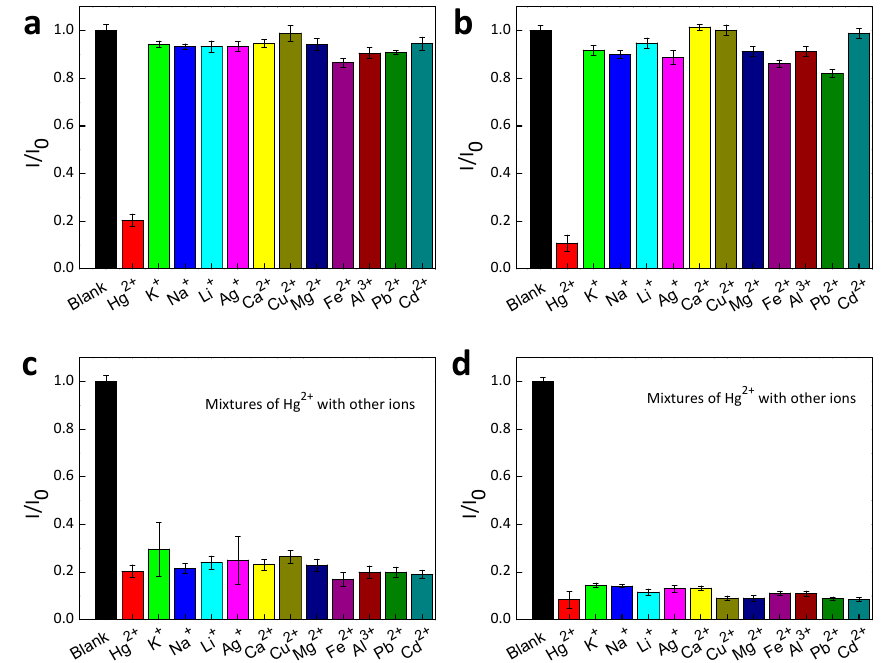
Figure 5. Selectivity test for M1 ( a , c ) and M1Q ( b , d ) in the presence of single ( a , b ) and co-existing ( c , d ) metal ions. The error bars represent the standard deviation of three independent measurements. [M1] = [M1Q] = 1.0 × 10 − 6 M, [metal ion] = 2.0 × 10 − 6 M.